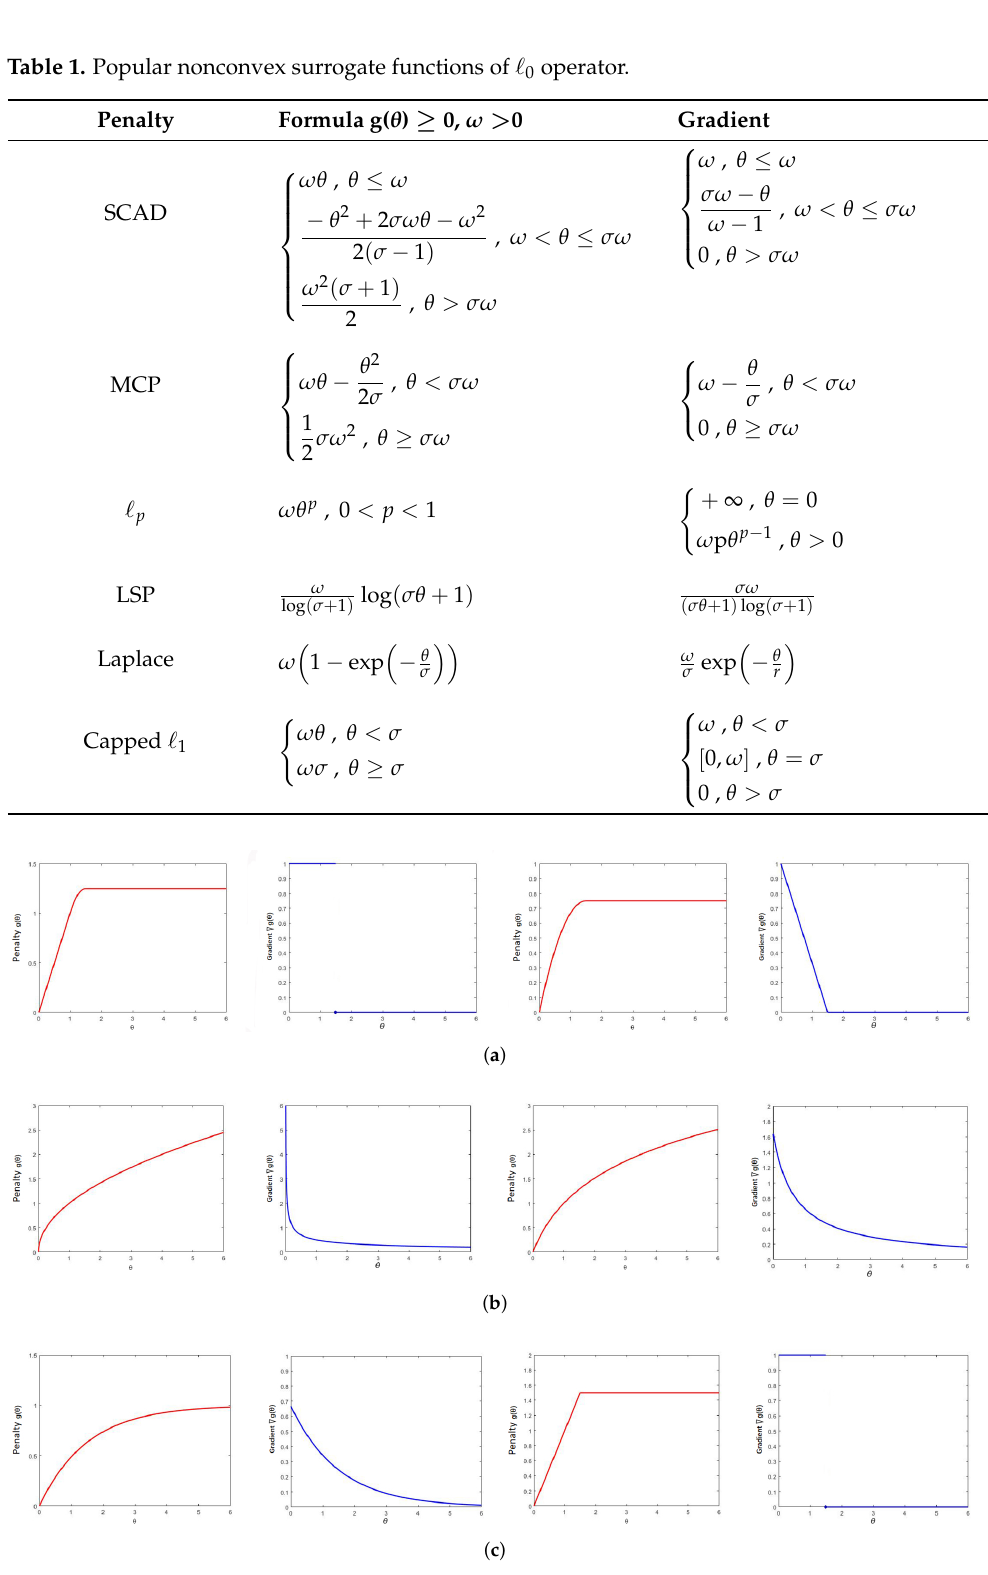
Figure 1. Visualizing the non-convex functions and their gradients of some commonly used (cid:96) 0 . ( λ = 1, γ = 1.5): ( a ) SCAD and MCP. ( b ) (cid:96) p ( p = 0.5 and ∇ g ( 0 ) = ∞ ) and LSP. ( c ) Laplace and Capped (cid:96) 1 ( ∇ g λ ( γ ) = [ 0, λ ]